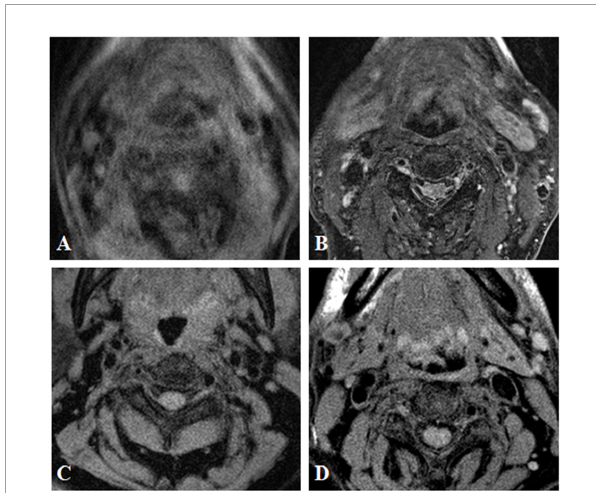
FIGURE1 MR image quality evaluation of carotid plaque. The image quality of transverse axial T2WI showed carotid plaque was divided into grade